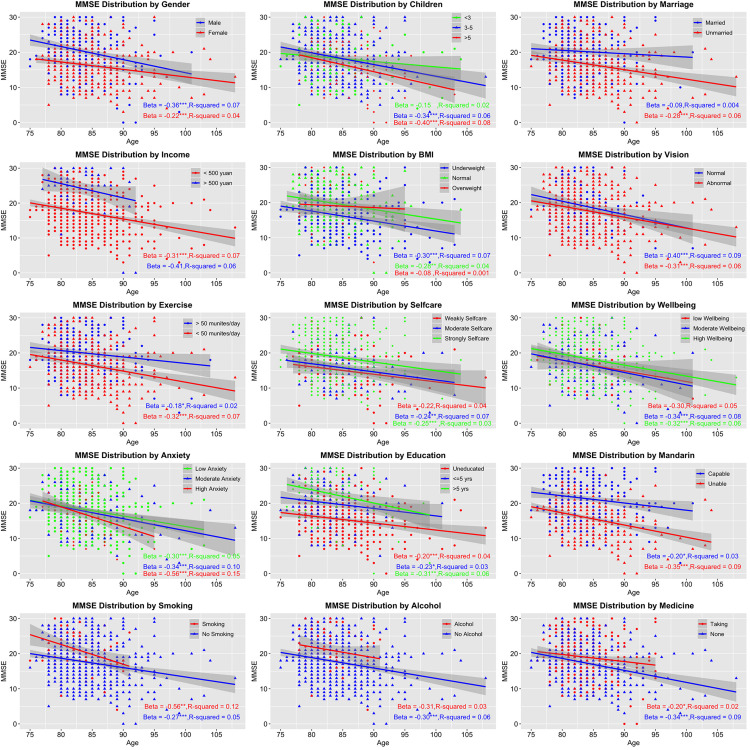
Age-related trends of cognitive changes by stratified factors. The vertical axis presents Mini-Mental State Examination (MMSE) score symbolizing cognitive statue; the horizontal axis presents age. Beta (the strength of association) and R-square (effect size) of each stratified factor were also calculated. *p < 0.05; **p < 0.01; ***p < 0.001.